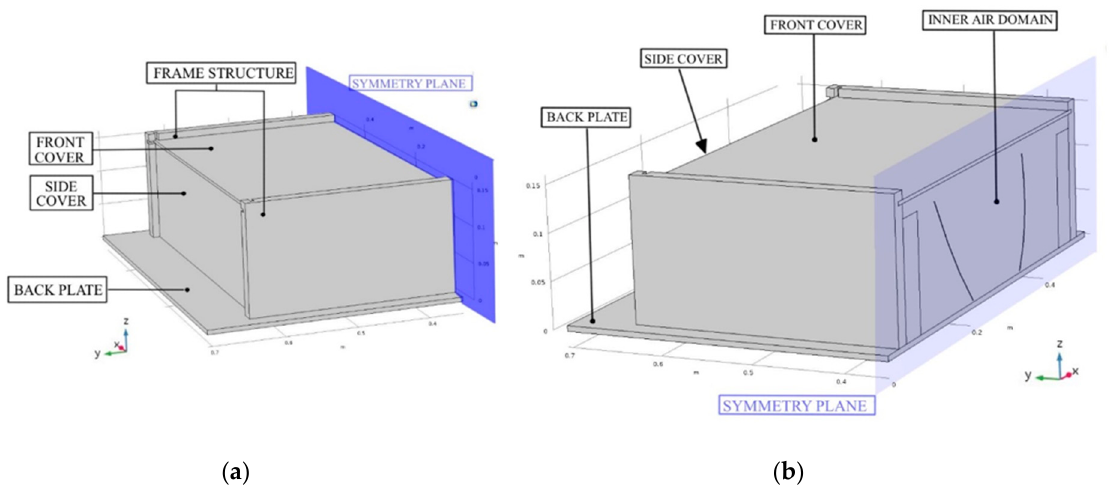
Figure 5. Inner components of the whole CPC system.